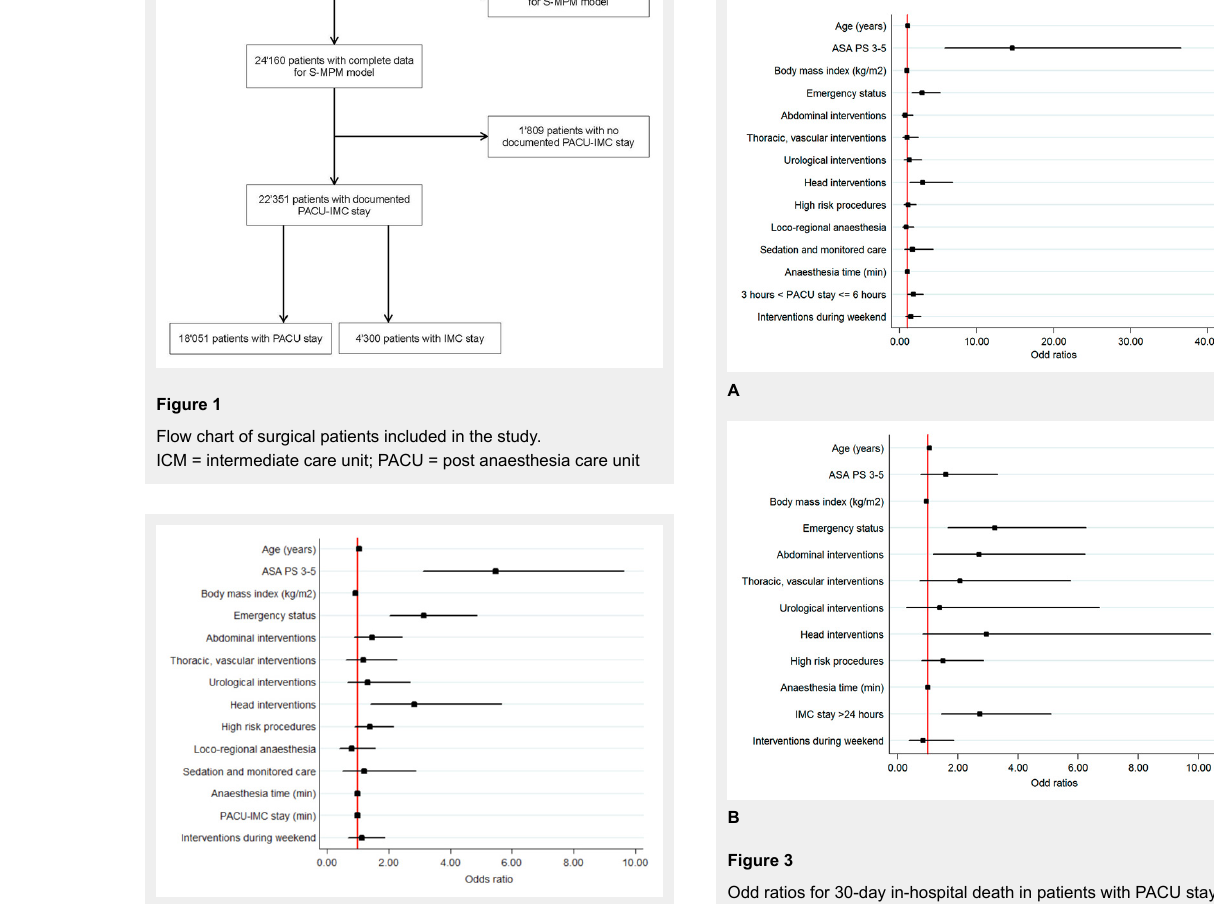
Odd ratios for 30-day in-hospital death in all patients (see also table 3a, multivariate models). ASA PS 3-5 was assessed versus ASA PS 1-2; emergency (nonelective) status versus elective; abdominal, thoracic – vascular, urological, head intervention versus orthopaedic; high-risk procedures versus low- and intermediate-risk procedures; locoregional anaesthesia, sedation and monitored care versus general and combined anaesthesia; interventions during weekend versus interventions during weekdays.